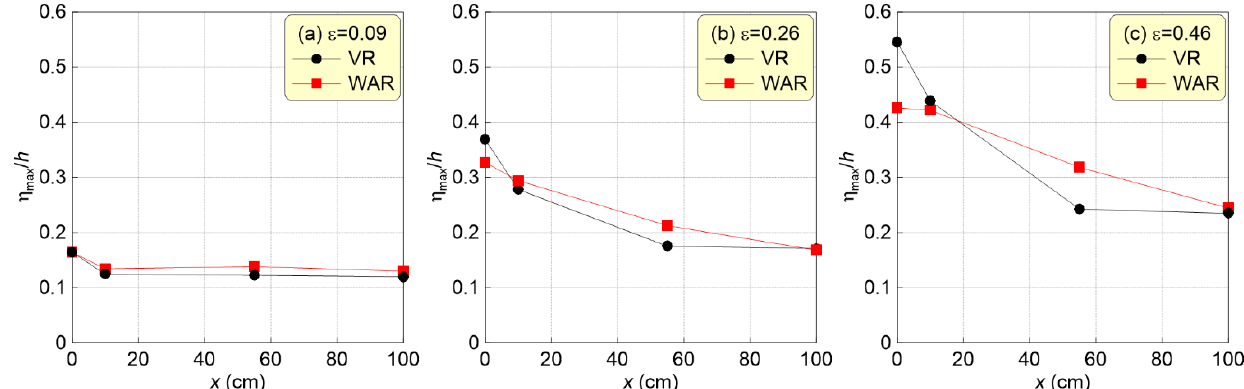
Figure 6. Comparisons of maximum surface elevations at the VR and WAR.